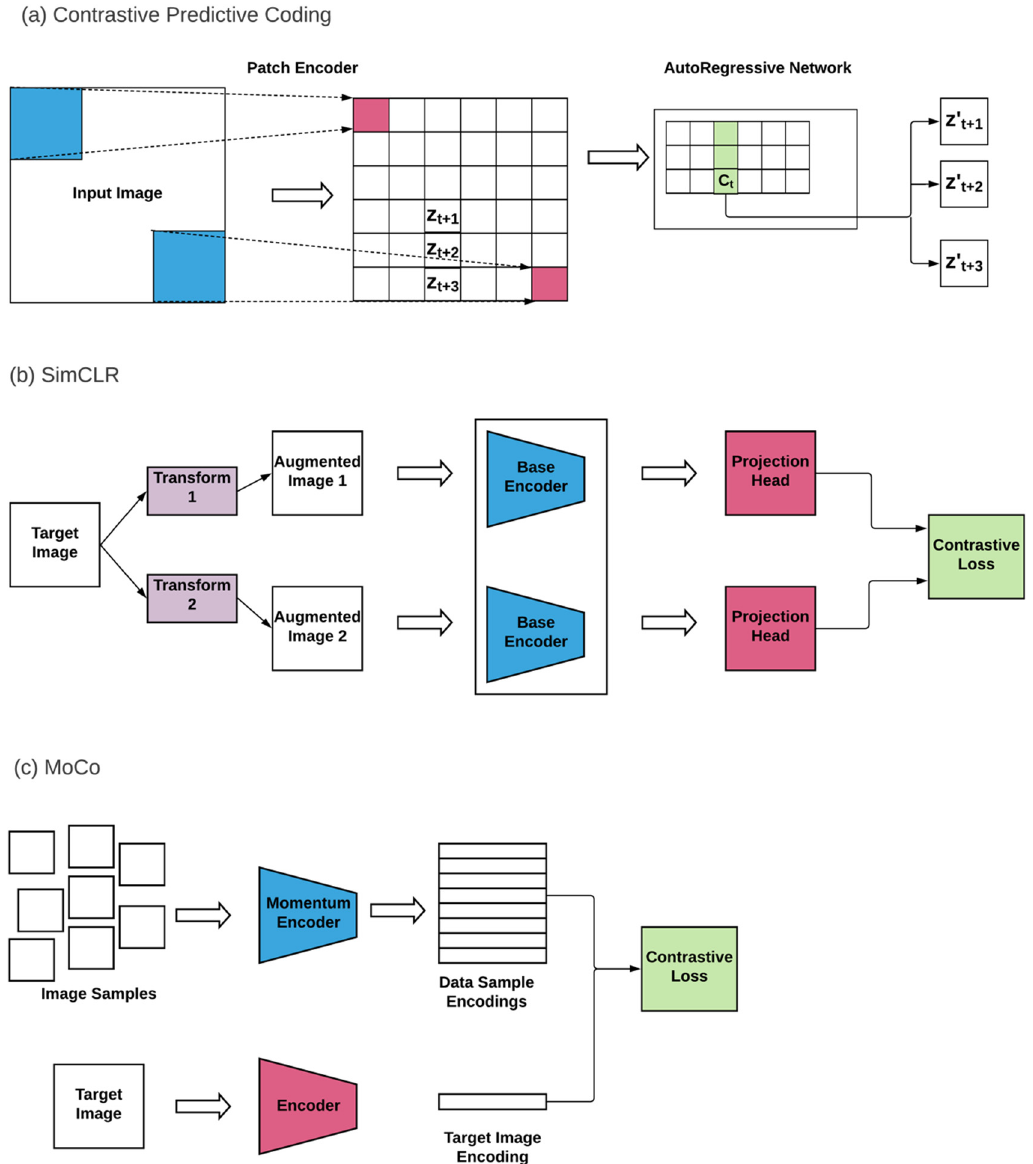
Figure 12. ( a ) An illustration of the algorithm used in [20]. An image is divided into overlapping subsections, which are then encoded with their relative spatial locations preserved. An autoregressive network then takes the top section of a column, encodes this into a context vector, and uses this to make predictions about the following rows in the corresponding column. ( b ) An illustration of the algorithm used in [31]. An image is transformed in two different ways and the encoded. These encodings are then passed to a contrastive loss function along with several negative encodings. ( c ) An illustration of the algorithm used in [32]. A random group of image samples is encoded by a dictionary encoder. A target image is then encoded by a separate encoder, and all samples are passed to a contrastive loss.